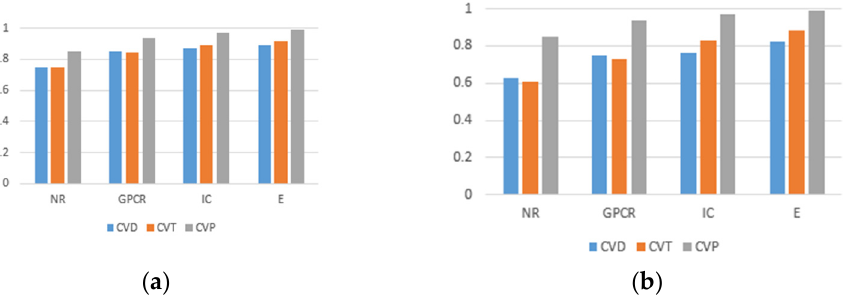
Figure 10. The AUC values and AUPR values of experimental results under three division methods. ( a ) AUC values of prediction results. ( b ) AUPR values of prediction results.